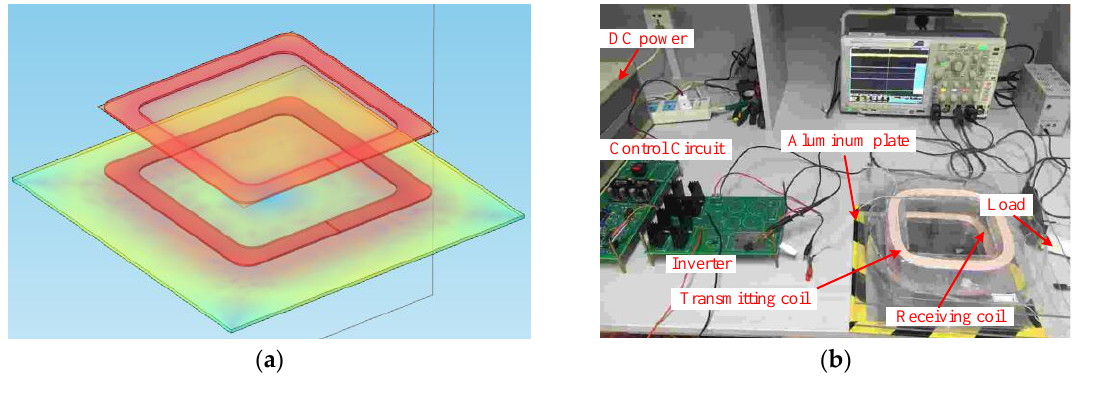
Figure 8. ( a ) Simulation model; ( b ) Experiment model.